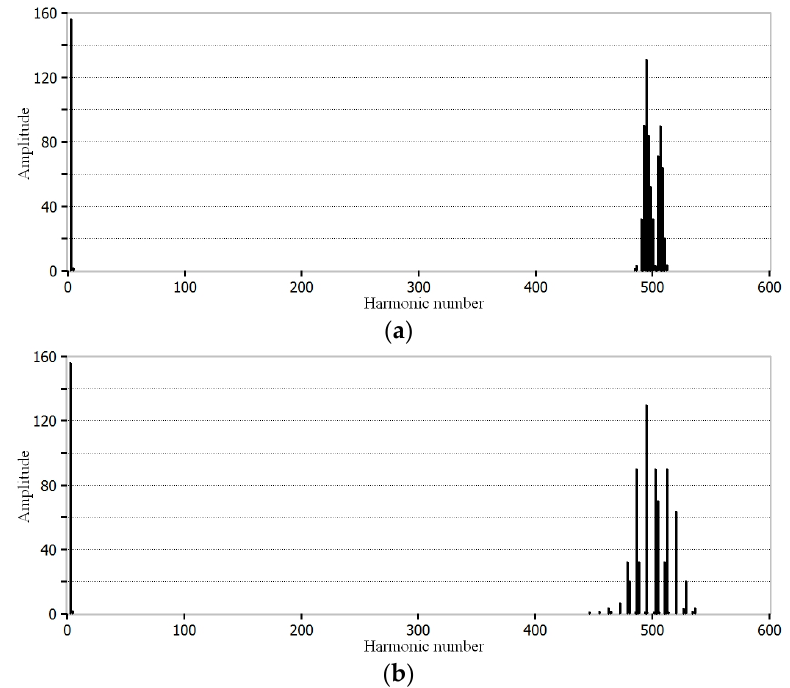
Figure 10. Fourier analysis of phase output voltage for ( a ) CCW method and ( b ) CW method.